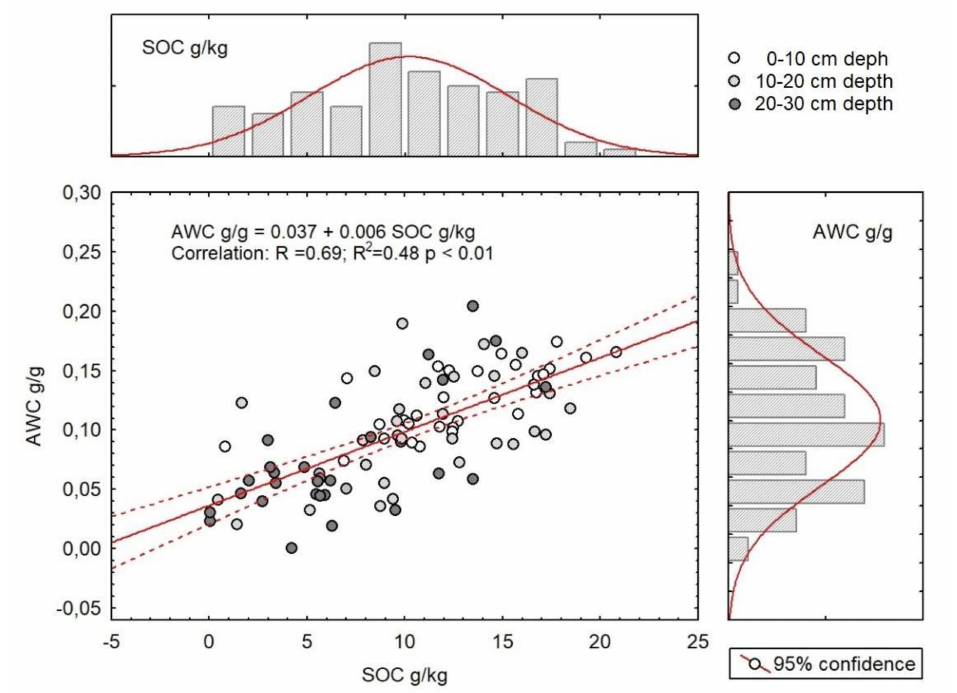
Figure 4. Cross-validation results of ParLeS software for soil physical–chemical variables. Observed versus predicted